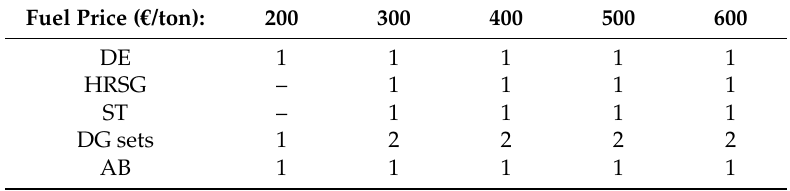
Table 35. Effect of fuel price on the optimal synthesis of the system for double freight rate.